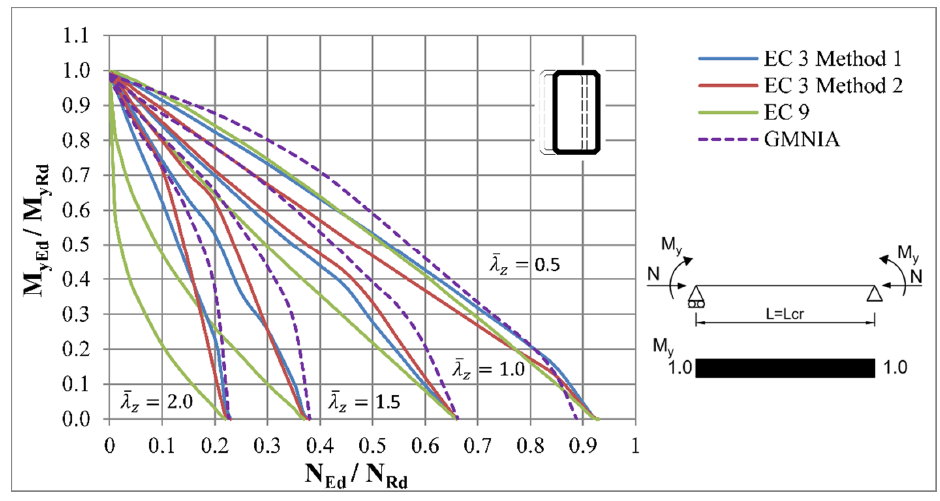
Figure 38. Interaction curves for beam-columns with RHS cross-section without lateral restraints.